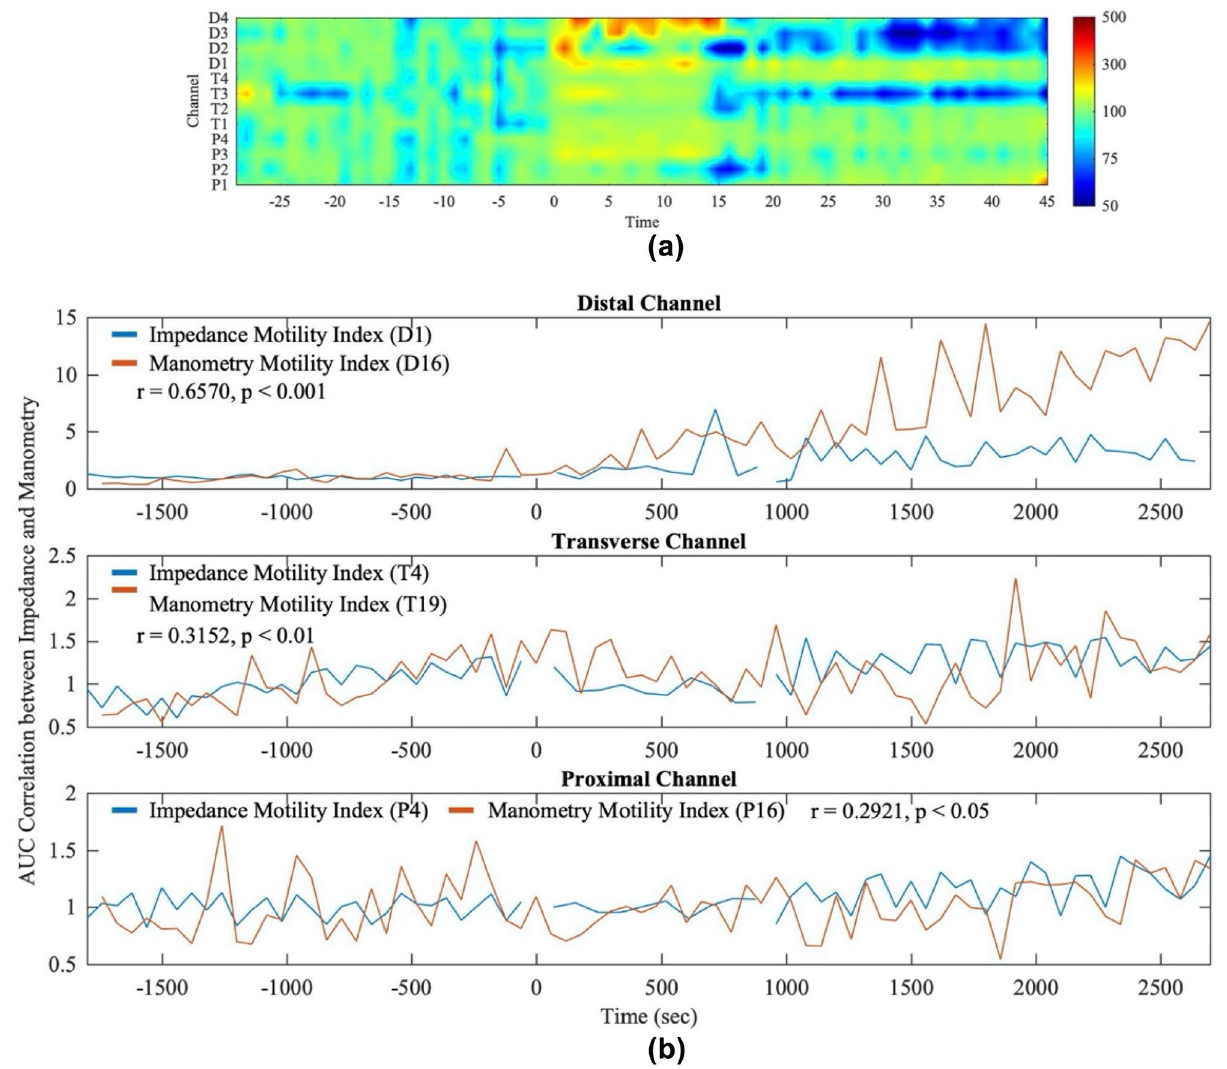
Figure 5. Bio-impedance motility and the correlation between the impedance motility index and manometry motility index. ( a ) Motility heatmap plot of bio-impedance. The color represents the percentage of the relative motility index change with respect to the baseline. The x-axis is time in minutes and y-axis is the channel index. ( b ) Representative results of AUC correlation between impedance channel and manometry probe in proximal (P4 and P16), transverse (T4 and T19), and distal colon (D1 and D16). Stimulation starts at 0 s, and end at 900 region, which corresponded to the significant impedance changes. After the stimulation, the recording region gradually relaxed and became less active, while the contractile activity started a short propagation and caused colonic activation at the surrounding area. Therefore, the spatial resolutions with two different modalities may contribute to the differences between current bio-impedance and manometry data. Bio‑impedance changes in frequency domain. As described in our previously reported manom- etry results 23,50–53 , the frequency band of interest showing the phasic contraction lies in the range of 0–12 cpm. The ventilator/breathing frequency band is 13–17 cpm and the power of higher frequency band is negligible. Manometry data has a dominant frequency band of 1–6 cpm. However, the dominant frequency is difficult to be identified in the manometry data because of the lower resolution of manometric recordings and the dense peaks within 1–6 cpm. On the other hand, frequency spectrum analysis of the bio-impedance appears to be a better indicator for the phasic contraction. Clear dominant frequencies (frequencies from which most contrac- tion power originates) of bio-impedance exist in the majority of the proximal, transverse, and distal channels during both baseline and post-stimulation period. Our results further narrowed down the range of dominant frequency to 2–3 cpm, which corresponded to the rhythmicity frequency that appeared in the aforementioned time course of bio-impedance changes. The high-resolution change of bio-impedance frequency further reveals the colonic motility profile. Figure 6 shows an example of the bio-impedance spectrum during baseline (blue) and post-stimulation (red) from one single experiment. The dominant peaks at around 2 cpm shifted to the right